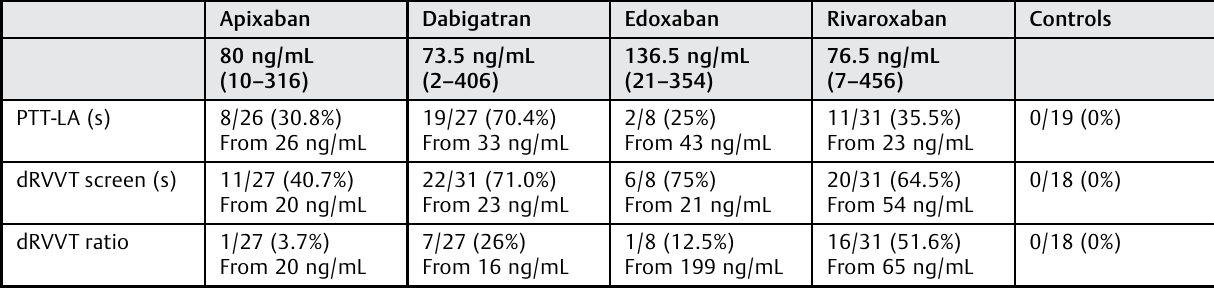
Table 2 False-positive LA results caused by DOACs